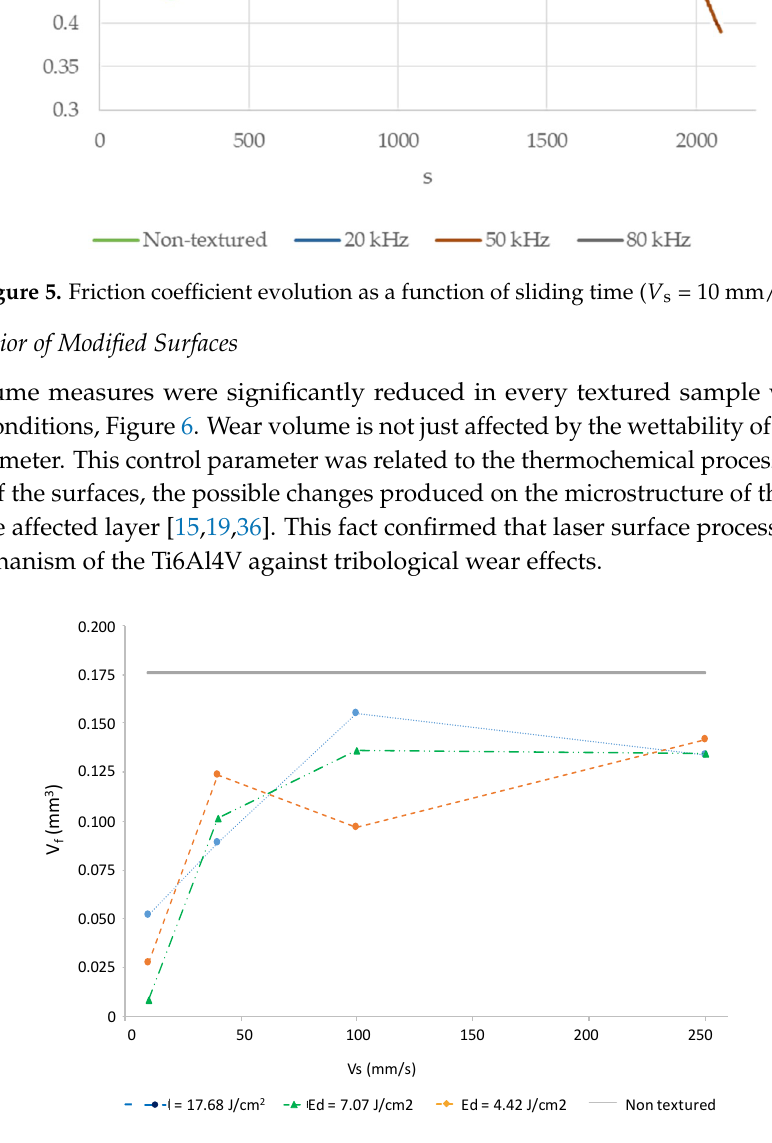
Figure 7. Worn morphologies of sliding track as a function of V s .